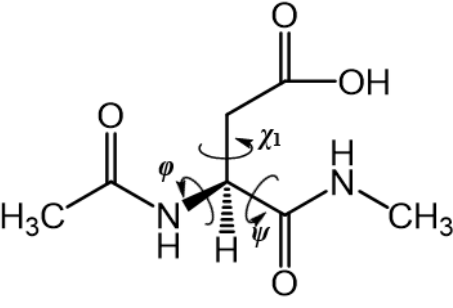
Figure 1. Chemical structure of the model compound Ace‒Asp‒Nme.